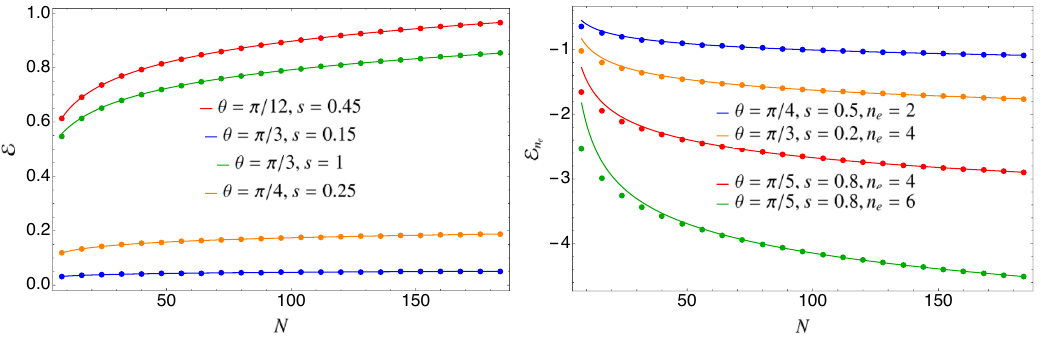
in the three-wire junction for different values of s, θ and as a e